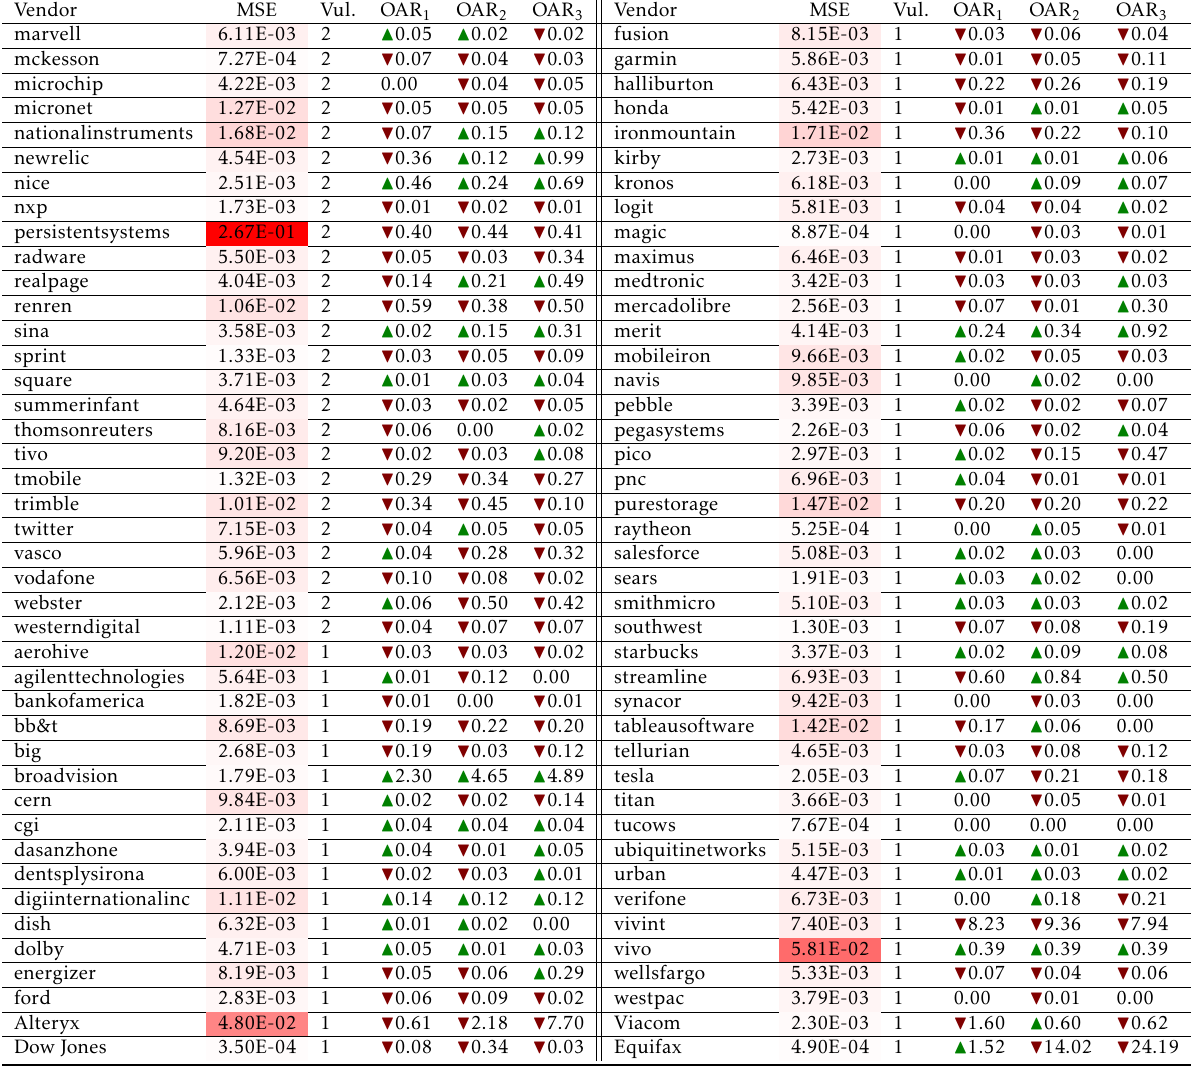
Table 4. Results for vendors with low vulnerability count. Symbols mean the same as in Table 3. (2) Vendor names are abbreviated as follows: bankofam.=Bank of America, digii.=Digi International Inc, dent.=Dentsply Sirona, tableau.=Tableau Software, agilent.=Agilent Technologies, persist.=Persistent Systems. (cid:78) : vulnerabilities had no overall impact on vendor’s stock value. (cid:72) : the stock of the vendor were